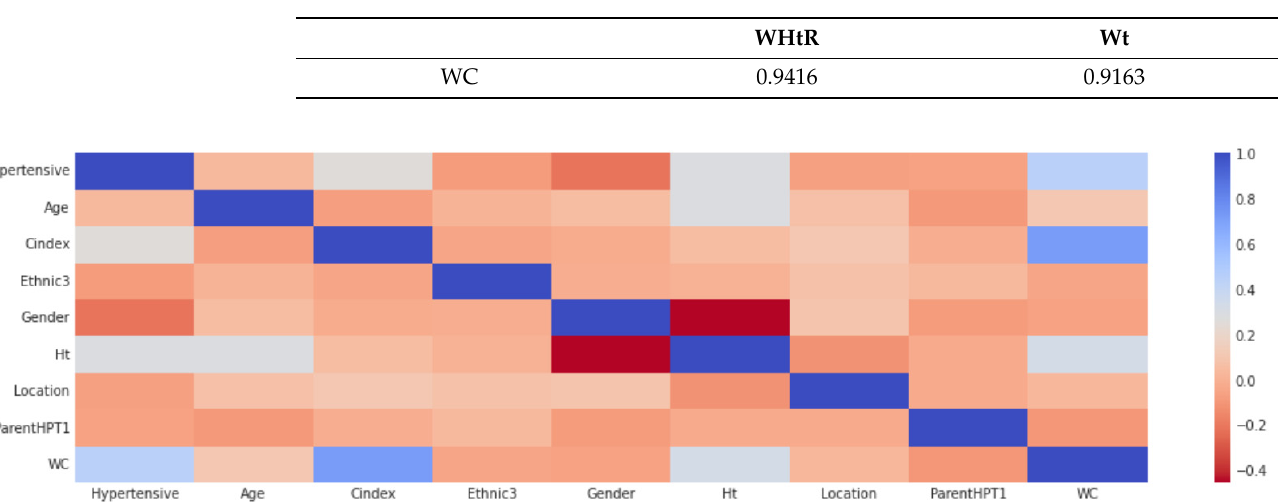
Figure 3. Heatmap showing the correlation coefficient of the 8 selected features: hypertensive, age, C Index (Cindex), ethnicity (Ethnic3), gender, height (Ht), location, parental hypertension (Paren- tHPT1), and waist circumference (WC).